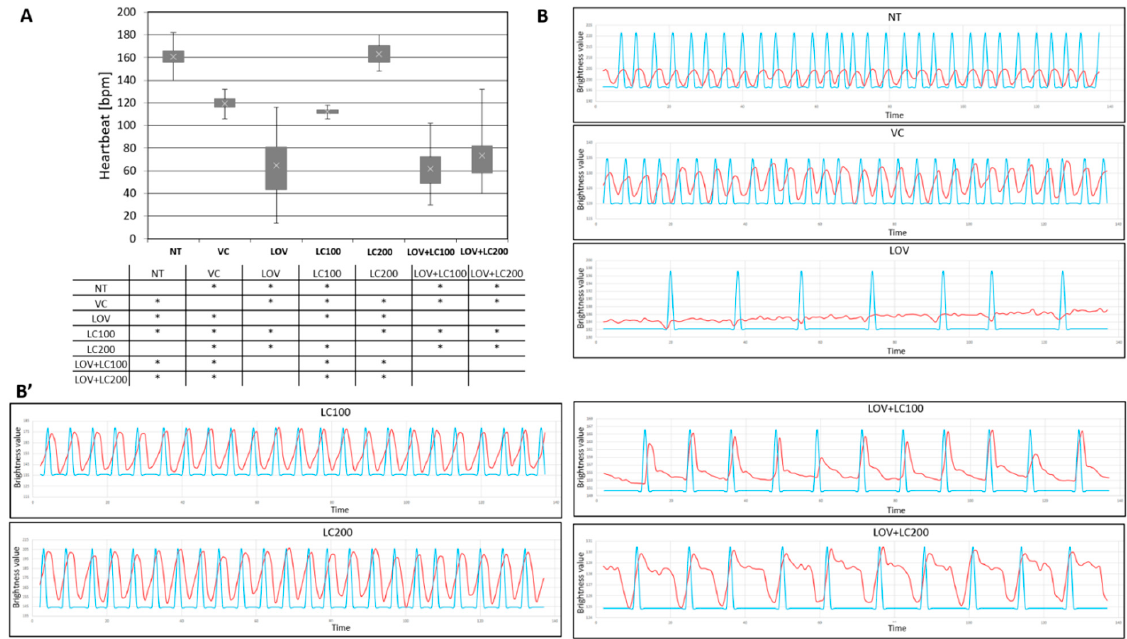
Figure 5. Heartbeat analysis of 120 hpf zebrafish larvae exposed to lovastatin (LOV) and L ‐ carnitine (LC) treatment. ( A ) Bar graph demonstrates heartbeats of zebrafish larvae in control (non ‐ treated, NT; vehicle control, VC; 100 μ M L ‐ carnitine, LC100; 200 μ M L ‐ carnitine, LC200) and experimental (0.5 μ M lovastatin, LOV; 0.5 μ M lovastatin and 100 μ M L ‐ carnitine, LOV+LC100; 0.5 μ M lovastatin